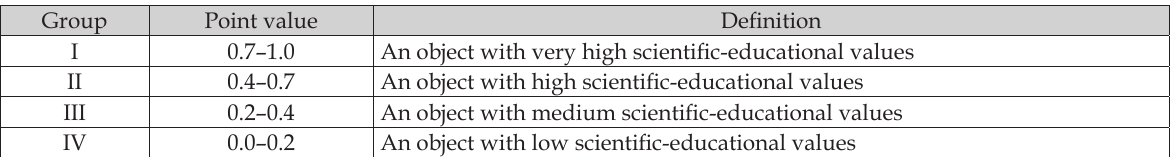
Table 2. Definitions of division into valorization groups. Based on Warszyńska (1970).